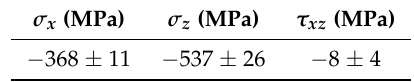
Table 3. Flat residual stress tensor implemented on the surface due to previous machining based on experimental